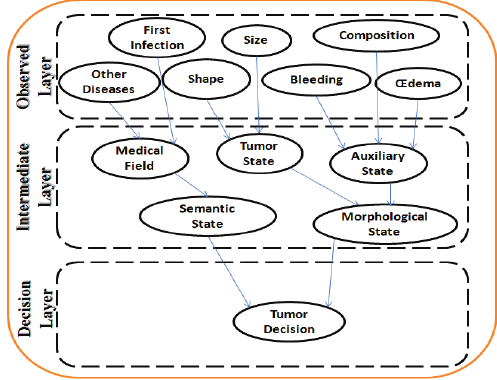
Fig. 4. Bayesian network architecture for Brain tumors